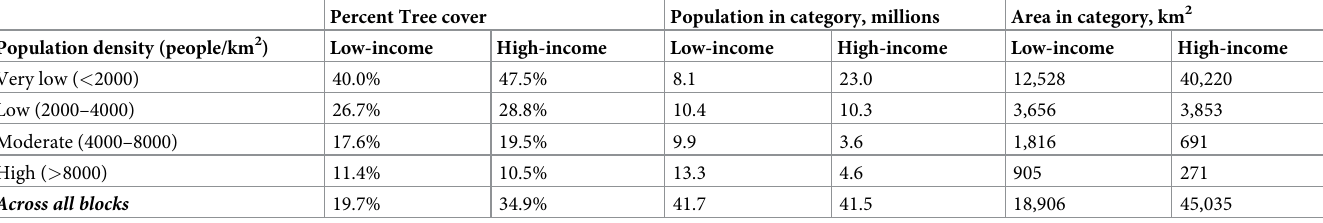
Table 1. Median tree cover, by population density and income